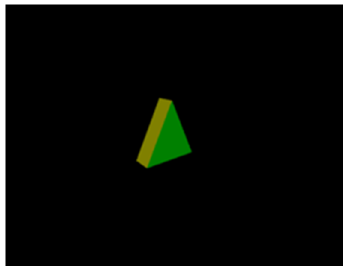
Figure 4. Screen showing a rotating figure.